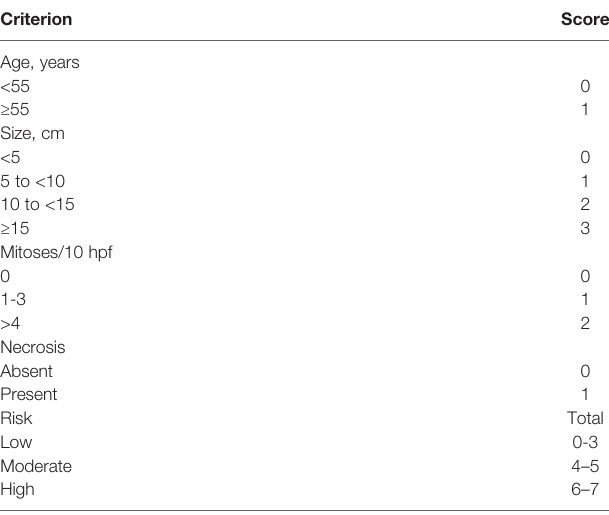
TABLE 3 | Risk strati fi cation systems for solitary fi brous tumor proposed by Demicco (Modi fi ed).